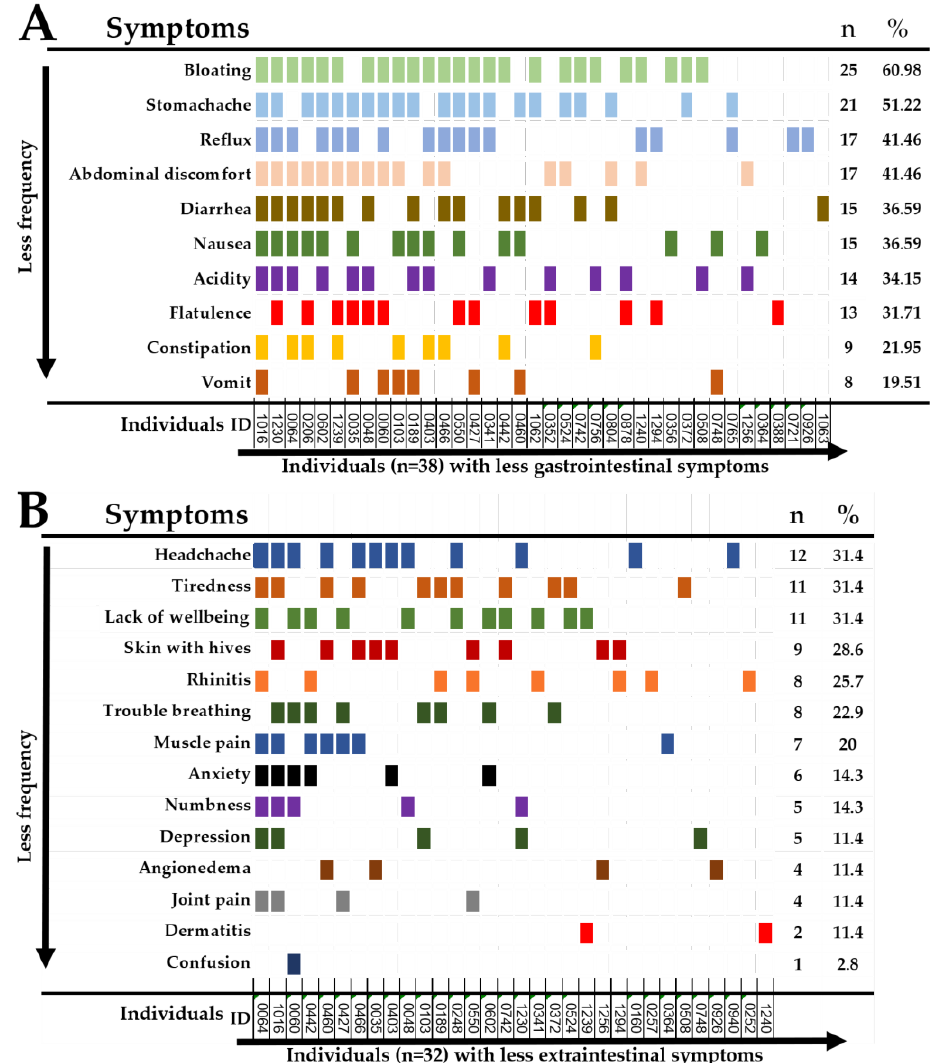
Figure 3. Recurrent self-reported symptoms in SR-GS individuals. ( A ); gastrointestinal symptoms, ( B ); extra-intestinal symptoms.